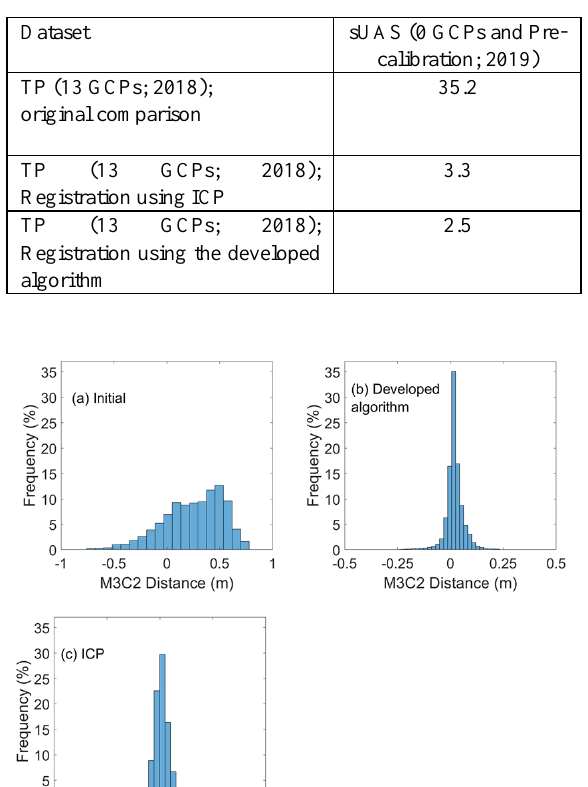
Table 1. Idaho Springs site. Registration RMSE values (in cm) for the sUAS dataset using the TP dataset as reference.